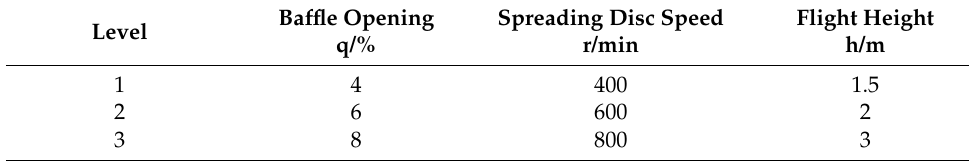
Figure 8. Schematic diagram of particle collection box arrangement for each treatment. ( a ) corresponds to the sampling point arrangement method in a single treatment; ( b ) corresponds to the T1–T9 ground sampling point arrangement; and ( c ) corresponds to the actual T1–T9 test site. Table 4. Orthogonal test factor